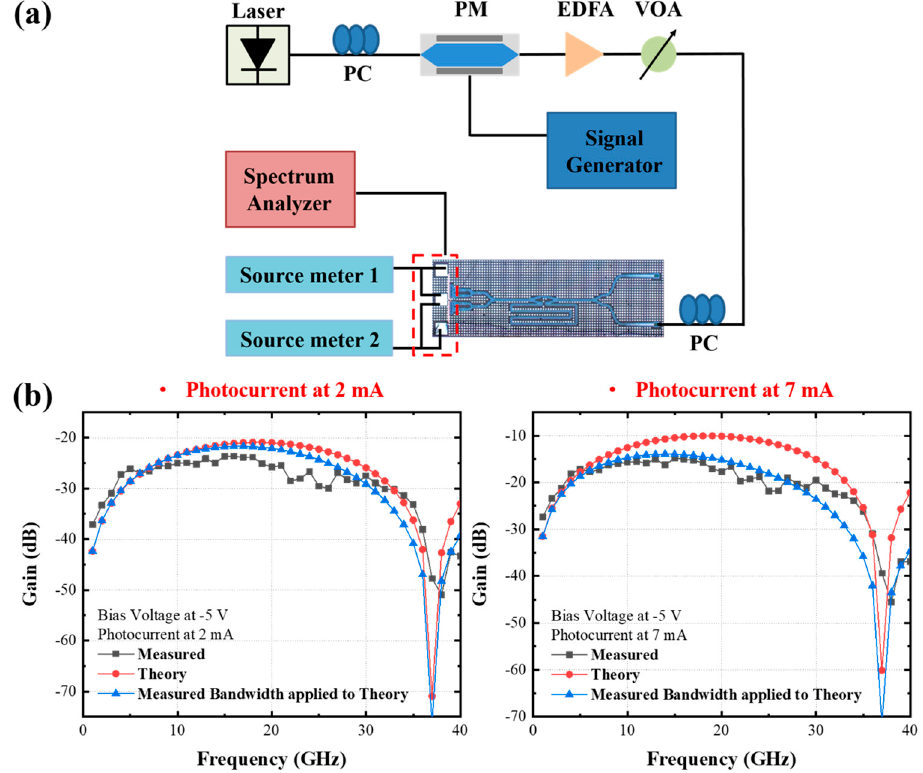
Figure 16. ( a ) Phase-modulated link gain measurement setup. ( b ) Measured and calculated RF gain